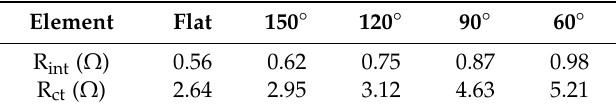
Figure 6 . Impedance spectra presented in Nyquist plots of Al-air batteries as a function of time.